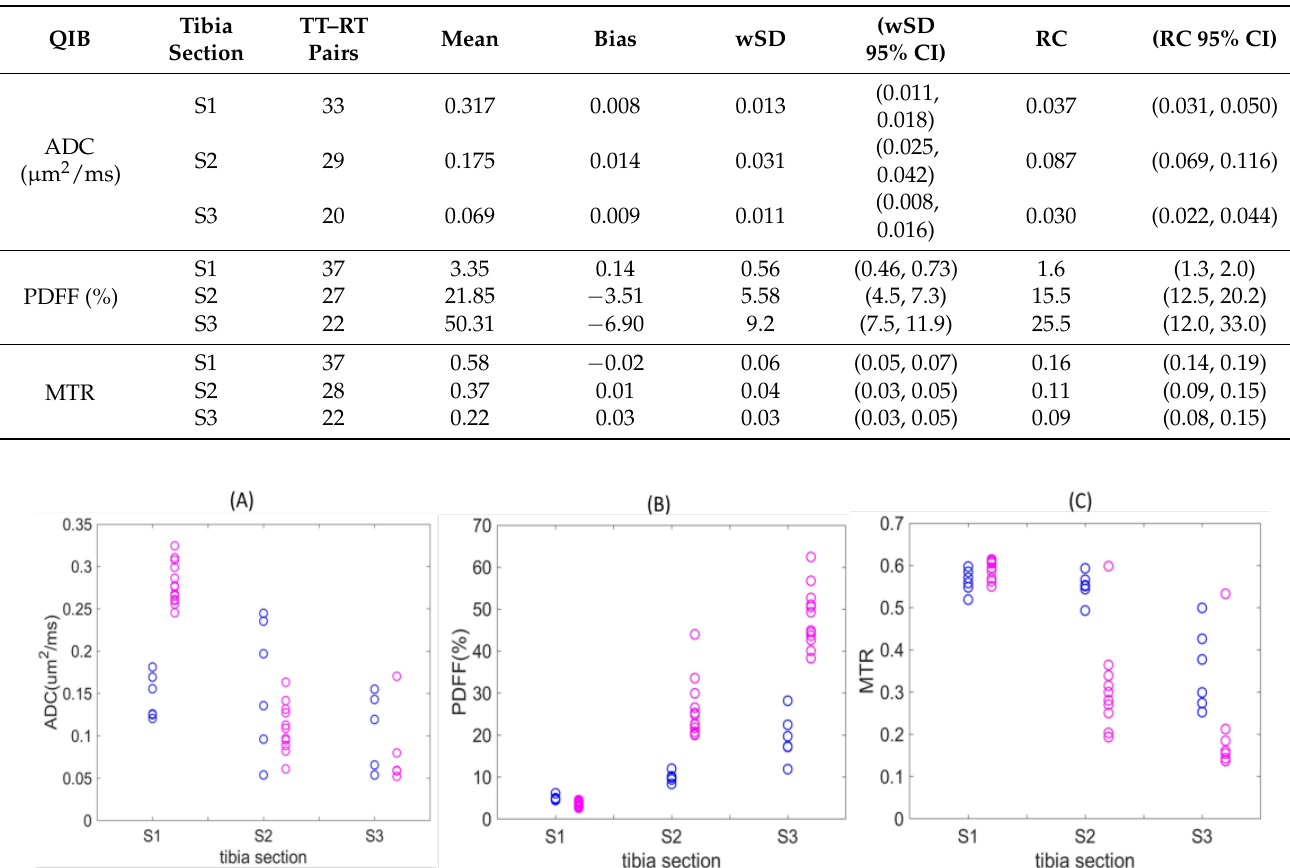
Table 1. Repeatability statistics for diseased mouse tibia bone-marrow section QIBs.